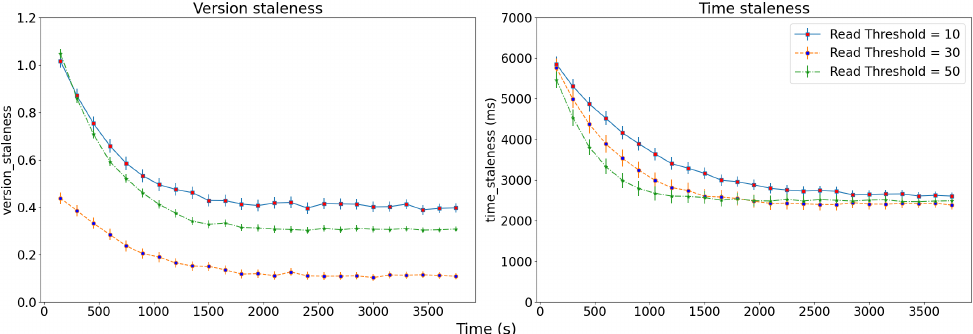
Figure 10. Version staleness and time staleness with different values of ThR